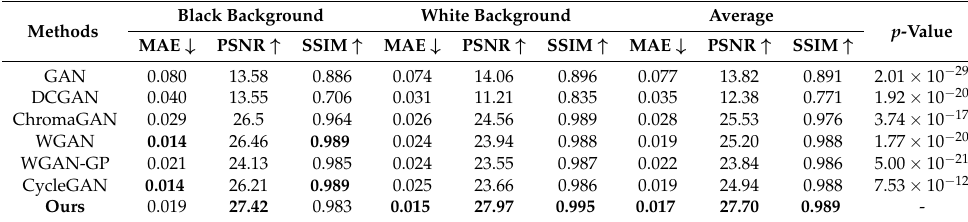
Table 1. Comparison results using different background images as input over cross-sectional cryosec- tion images in terms of the MAE, PSNR, and SSIM metrics. The small p -values ( p < 0.001) calculated between our method and the comparison approaches in terms of MAE indicate the improvements are significant. ↑ denotes higher the better and ↓ represents lower the better. The best results are marked in